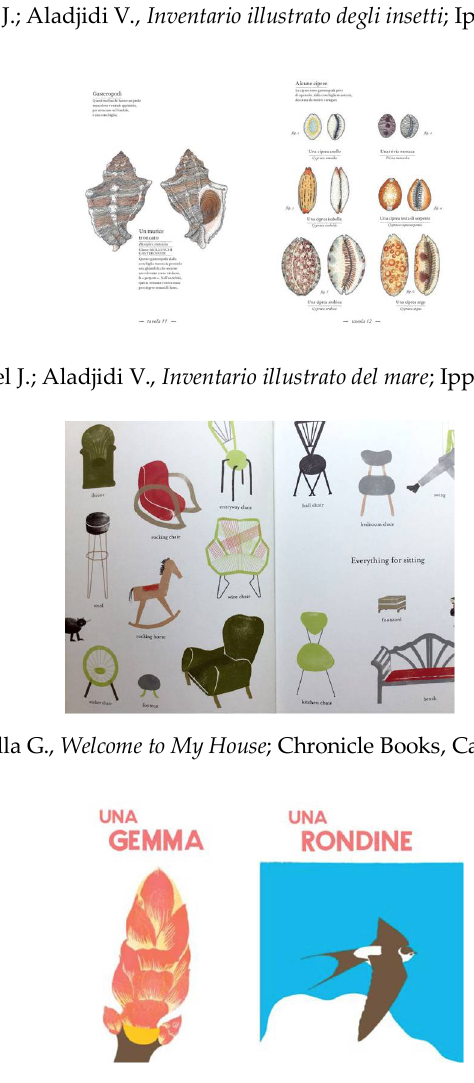
Figure 12. BlexBolex, Stagioni ; Orecchio Acerbo, Italia 2010,